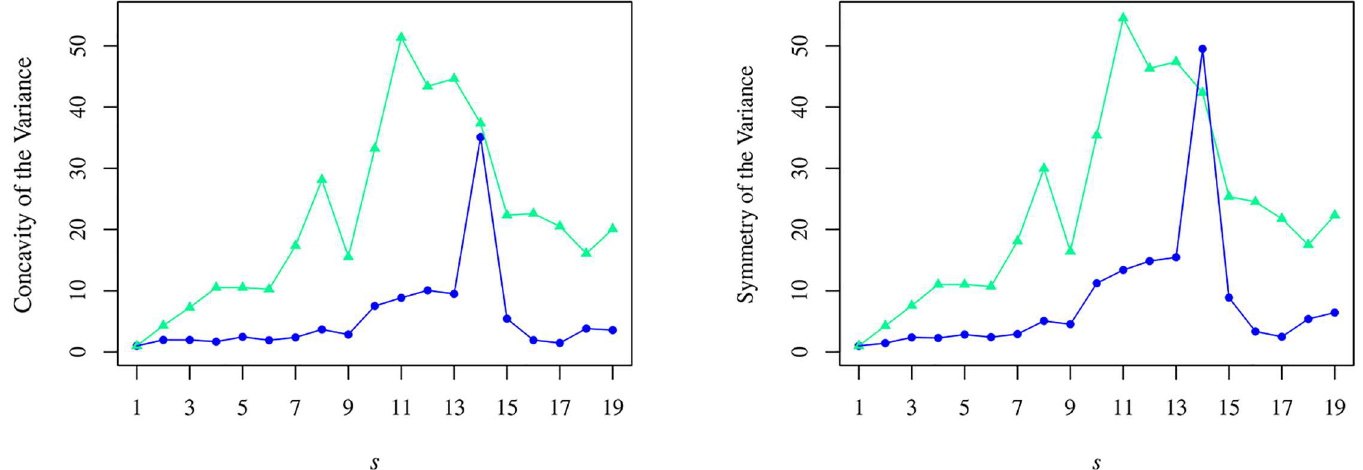
Fig 14. Individual and Cross-sectional Concavity (left) and Symmetry(right) v semester s . In both panels, the green triangles represent the cross- sectionalvariance, ^ s 2 , and the blue dots stand for the individualvariance, ~ s 2 . The values in the abscissae are normalisedby the value in the first